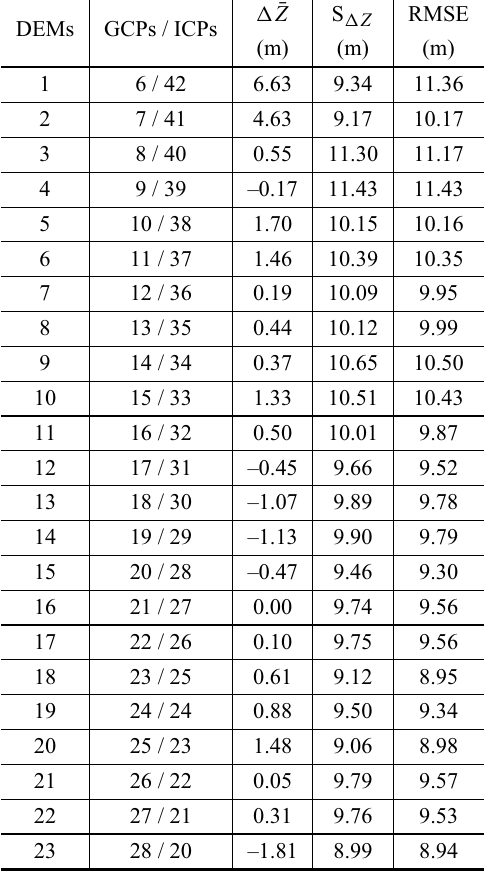
Results of the GCPs/ICPs combinations ( 1 ˉ Z = Mean of discrepancies, S 1 Z = Standard Deviation and RMSE = Root Mean Square Errors).